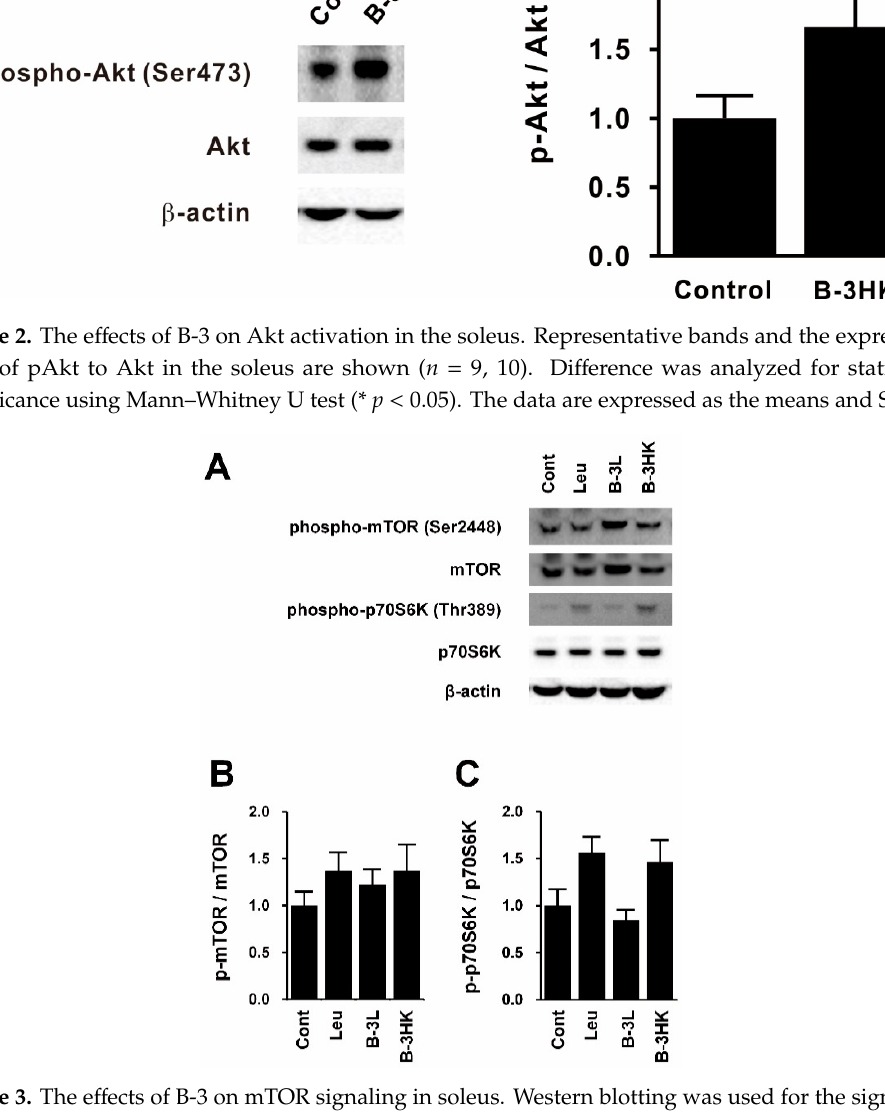
Figure 3. The effects of B-3 on mTOR signaling in soleus. Western blotting was used for the signaling pathways related protein synthesis in rat soleus muscle. ( A ) Representative bands and the expression ratio of ( B ) p-mTOR to mTOR and ( C ) p-p70S6K to p70S6K are shown ( n = 6). Leucine was used as a positive control for induction of mTOR. The data are expressed as the means and SEs. Abbreviations: Cont, control; Leu, leucine; B-3L, live B-3; B-3HK, heat-killed